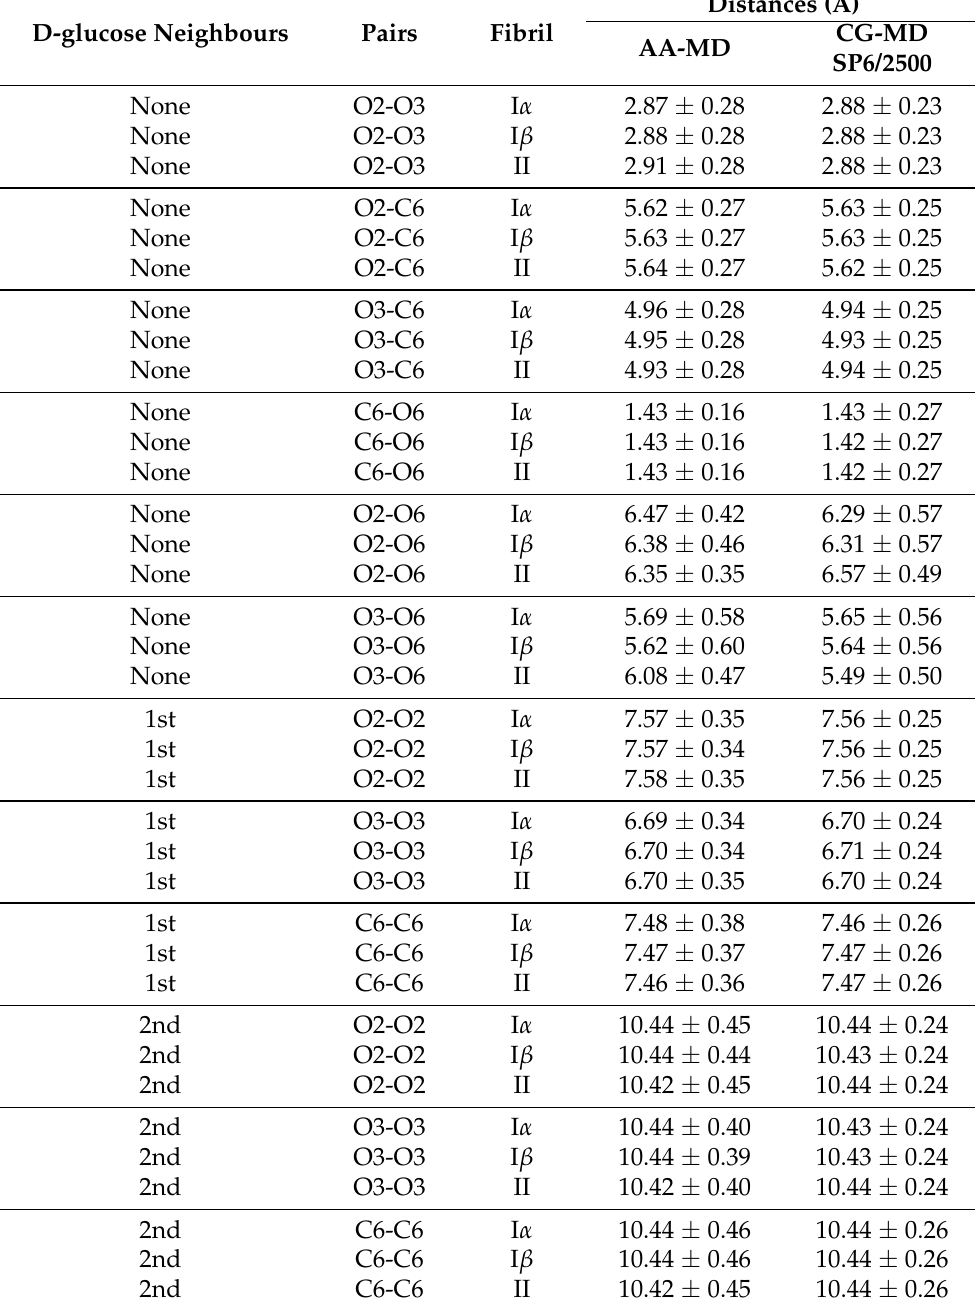
Table 3. Comparison of the distances between CG centres between AA-MD and CG-MD models for I α , I β , and type II fibrils. Mean value and standard deviation are shown for each entry. The first column indicates whether the distance is found inside the D-glucose (none) or between the two subsequent (1st and 2nd neighbours) D-glucose